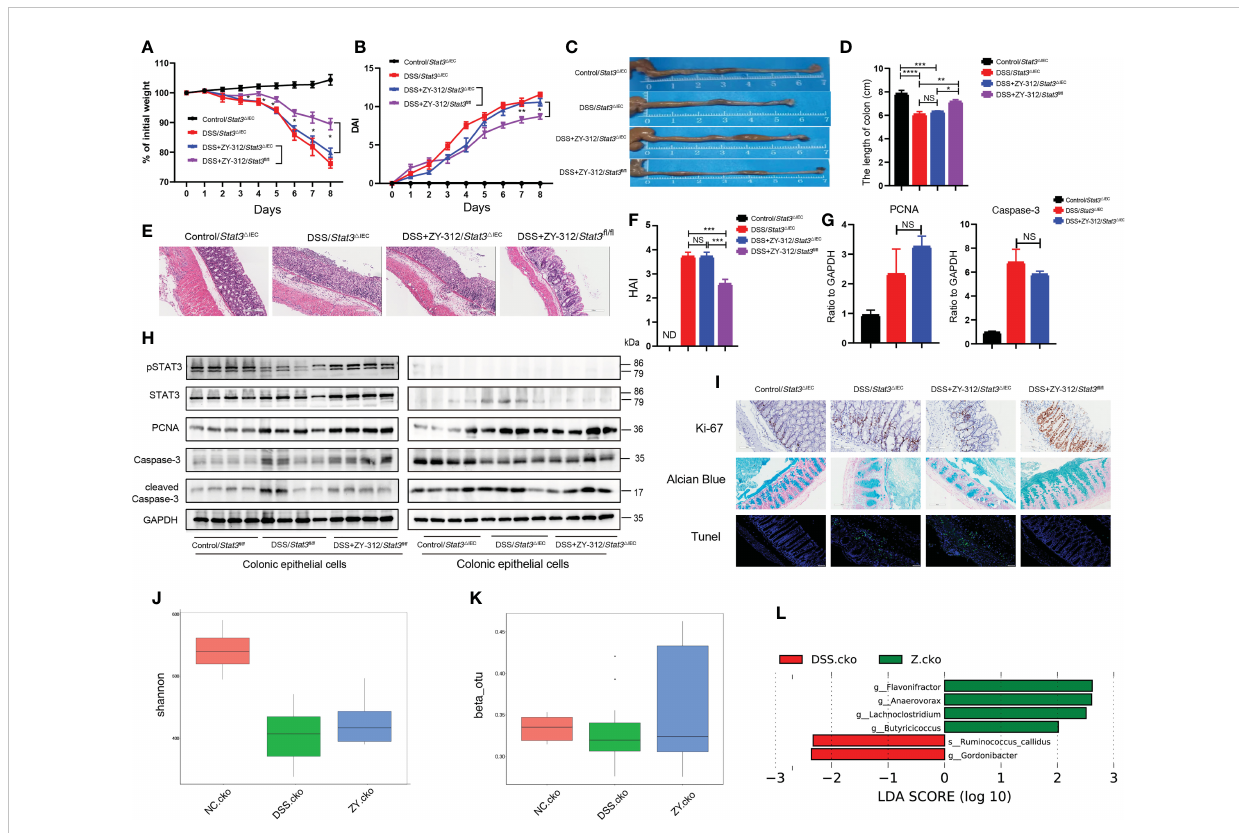
FIGURE 3 B. fragilis motivated STAT3 phosphorylation in colonic mucosa to promote colonic enterocytes and goblet cell proliferation, inhibit apoptosis, and alter gut microbiota. (A, B) Percent of weight loss (A) and DAI (B) were monitored daily starting from DSS administration. Control/ Stat3 △ IEC group (N=4), DSS/ Stat3 △ IEC group (N=7), DSS+ZY-312/ Stat3 △ IEC group (N=7), DSS+ZY-312/ Stat3 fl / fl group (N=7). N, number of mice. (C) Representative colon morphology. (D) Statistical analysis of colon length. (E) H&E staining of colon tissues. (Scale bars, 200 m m). (F) Statistical analysis of HAI. (G) qPCR analysis of PCNA and Caspase-3 in colon tissue. (H) Western Blot analysis of pSTAT3, STAT3, PCNA, cleaved Caspase-3, Caspase-3 in colonic epithelial cells. (I) Immunochemistry analysis of Ki-67 (upper), Alcian blue staining of mucus (middle), Tunel assay analysis (below) of colon tissue. (Scale bars, 200 m m). (J, K) The a (J) and b (K) diversity analysis of microbiota in Stat3 △ IEC mice between groups. (L) LEfSe analysis of differential bacteria in feces between the DSS group and ZY-312 group with different levels meeting a signi fi cant LDA threshold value of >2 in Stat3 △ IEC mice. NC.cko indicates Control/ Stat3 △ IEC group. DSS.cko indicates DSS/ Stat3 △ IEC group. Z.cko indicates DSS+ZY-312/ Stat3 △ IEC group. Data are presented as Mean ± SEM (A, B, D, F, G). Statistical analysis was performed using two-way ANOVA (A, B) , and one-way ANOVA (D, F, G) . * p < 0.05,** p < 0.01, *** p < 0.005, **** p < 0.001. ND indicates undetectable. NS indicates no signi fi